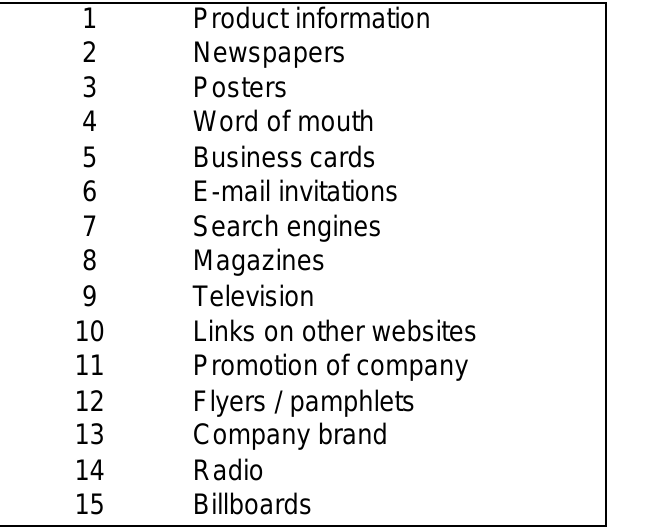
TYPE OF WEB SITE